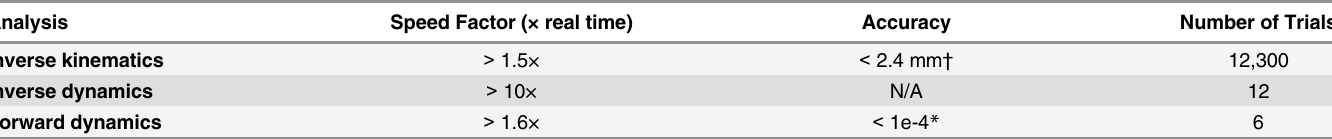
Table 3. Summary of computational speed and accuracy of scapulothoracic joint mechanics. Performance is presented as a ratio of the real move- ment duration to the computation period, where a result > 1 represents a factor faster than real time. Computation times evaluated from single threaded calcu- lations on an i7-2820QM 2.4GHz